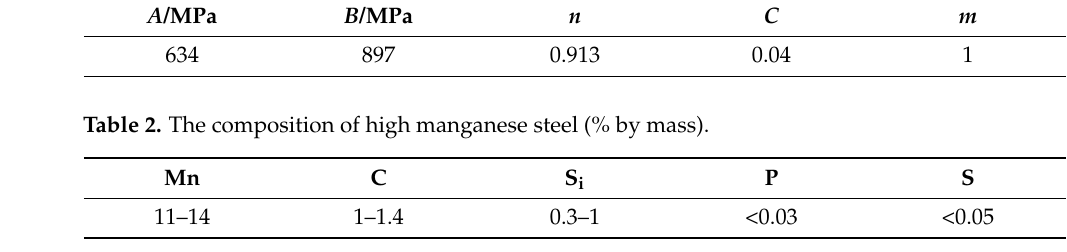
Figure 1. Model geometry and boundary conditions. Table 1. J-C model parameters of high manganese steel [26].